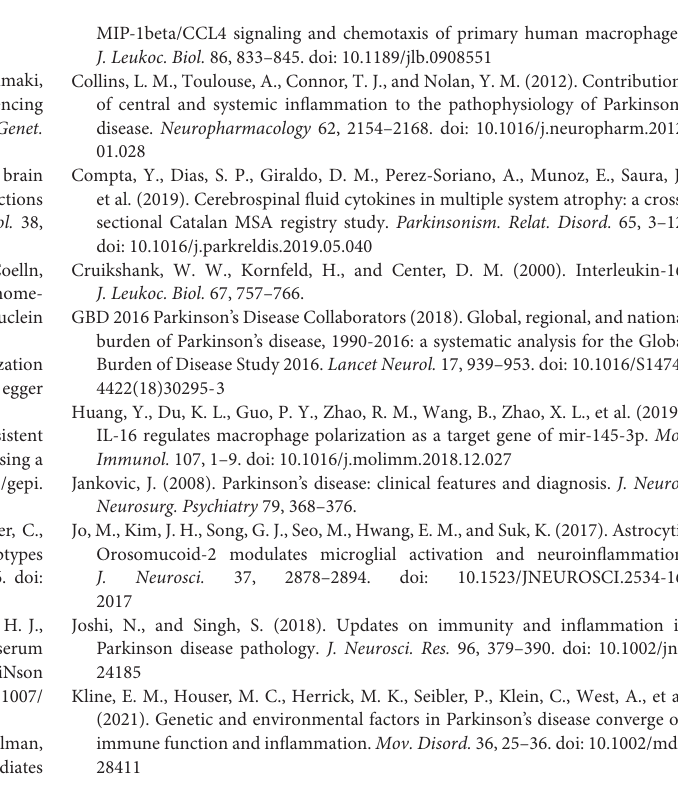
Supplementary Figure 1 | Forest plot of the causal effect estimates of MIP1b-associated SNPs on PD risk. Each black dot indicates the causal estimate of MIP1b on PD using an SNP by the Wald ratio method with 95% confidence interval bars. The MR estimate using all SNPs with the IVW method is also shown (red dot with 95% confidence interval bars). PD, Parkinson’s disease; SNP, single-nucleotide polymorphism; MR, Mendelian randomization; IVW, inverse-variance weighted. Supplementary Figure 2 | Leave-one-out analysis of MIP1b-associated SNPs on PD risk. It was conducted to determine whether the causal effect of circulating MIP1b levels on PD risk was disproportionately influenced by a single SNP. The black dot and bars indicate the MR estimate and 95% confidence interval when the specific SNP is removed. The overall MR analysis, including all SNPs, is also presented for comparison (red dot with 95% confidence interval bars). SNP, single-nucleotide polymorphism; PD, Parkinson’s disease; MR, Mendelian